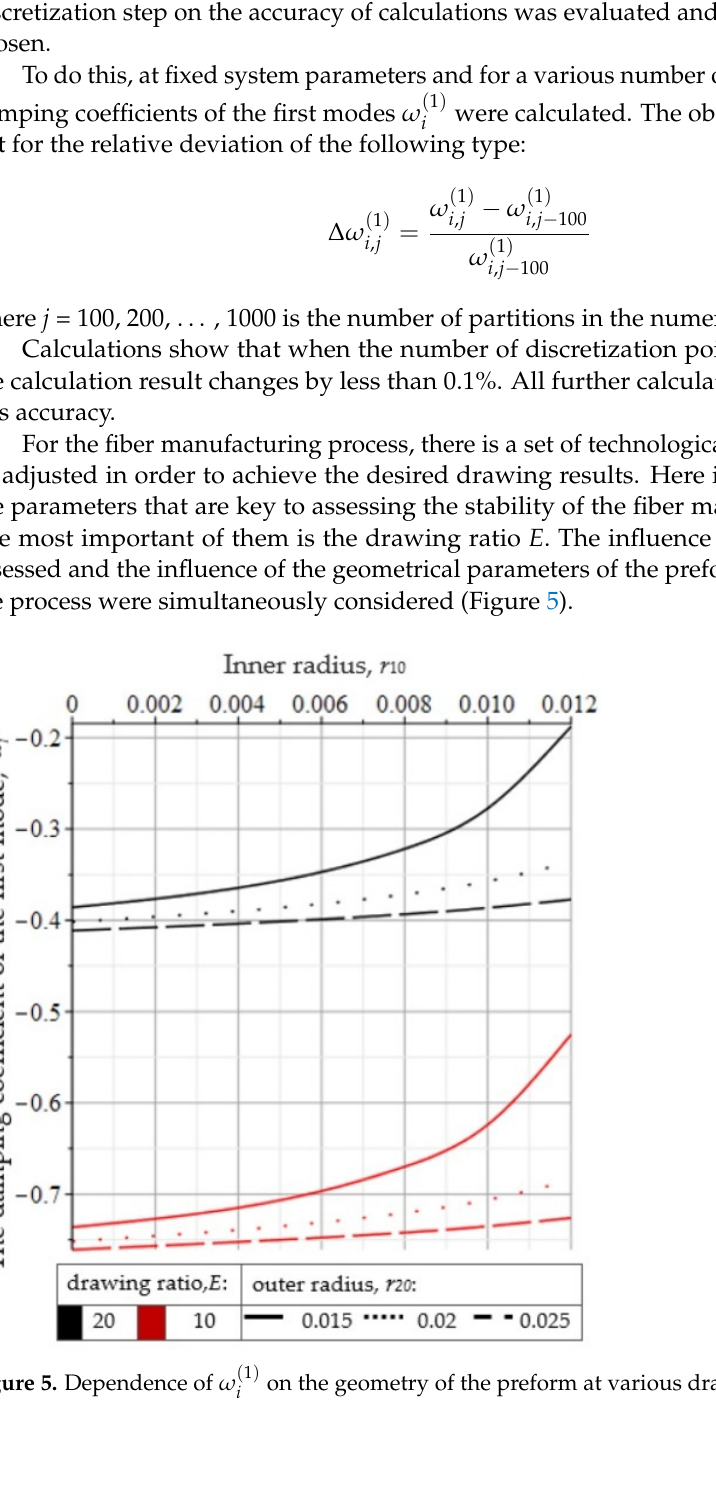
Figure 5. Dependence of ω